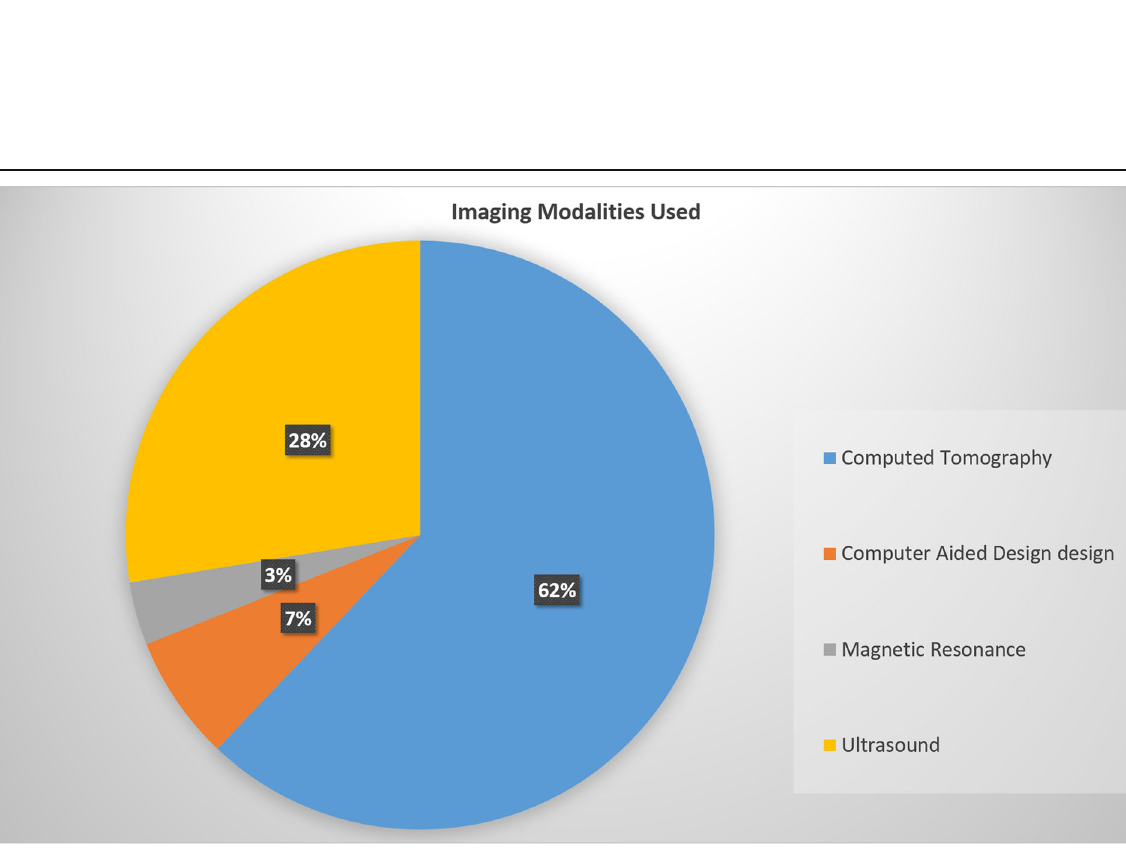
Fig. 2 Frequency of use of different imaging modality providing the source